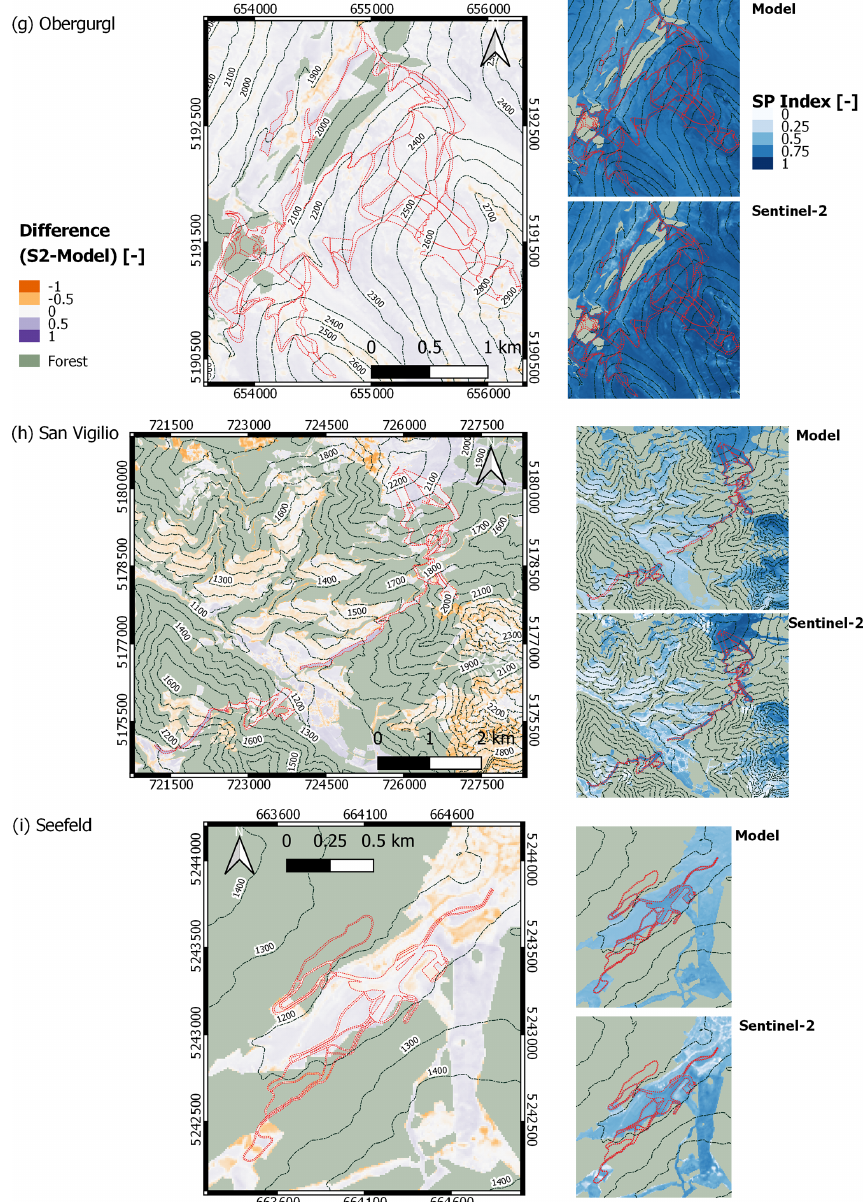
Figure 3. Snow persistence index difference between Sentinel-2 data and the model data (on the left) and SP indices for the simulation and Sentinel-2 (on the right) for each ski resort: (a) Arosa Lenzerheide, (b) Colfosco, (c) Garmisch Classic, (d) La Plagne, (e) Les Saisies, (f) Livigno, (g) Obergurgl, (h) San Vigilio, and (i) Seefeld. The period 2015–2020 was considered, when valid Sentinel-2 data are